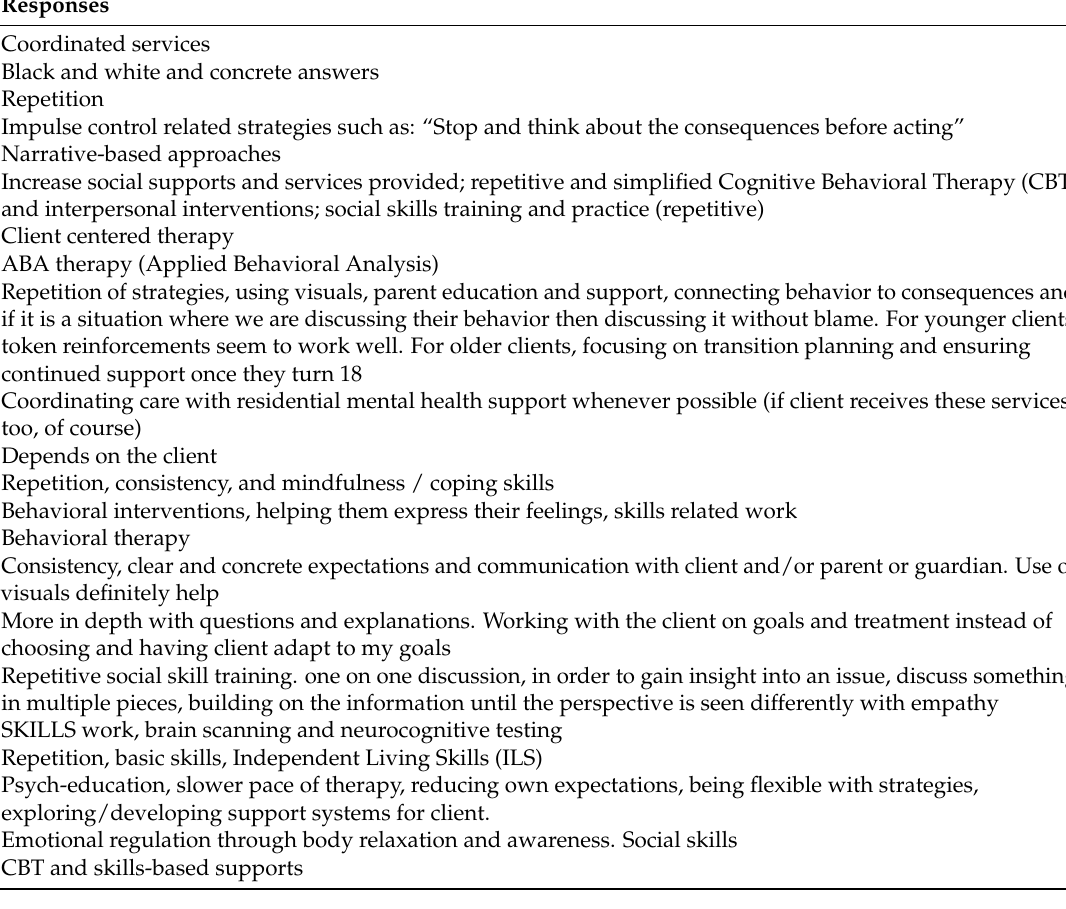
Table 1. Summary of